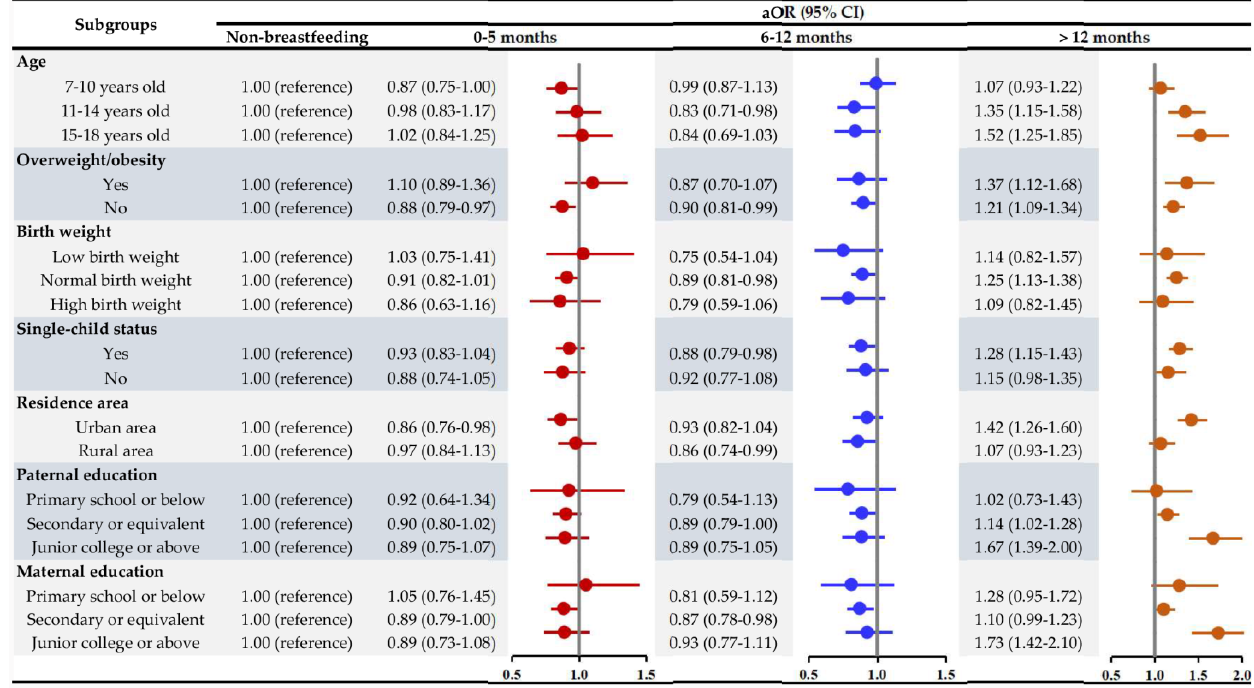
Figure 1. Associations between breastfeeding duration and high blood pressure in various subgroups. (Model: adjusted for age, sex, birth weight, single-child status, overweight/obesity status, residence area, maternal age at delivery, parental educational attainment, family history of diseases (hypertension, diabetes, heart disease, cerebrovascular disease and obesity), monthly household income, dietary behaviors (including fruit, vegetable, SSB and meat consumption), and physical activity.)